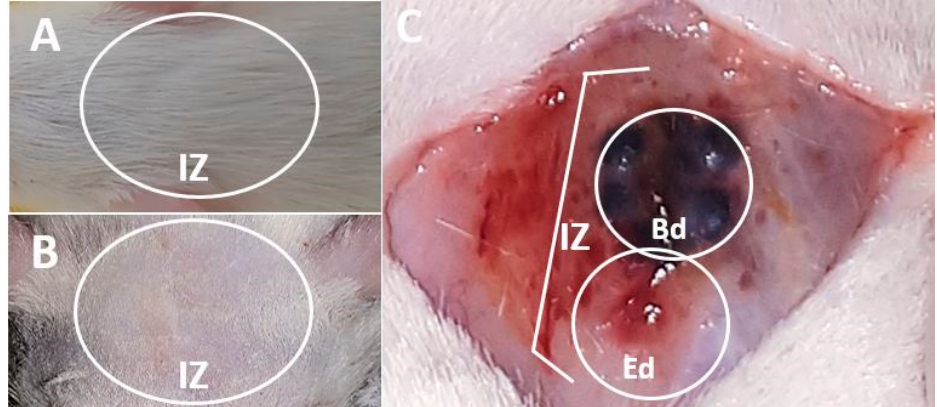
Figure 1. Macroscopic image of the skull intervened area. ( A ): Presence of hair. ( B ): Trichotomy. ( C ): Exposed bone area. IZ: Implantation zone. Bd: Beads. Ed: Empty defect.